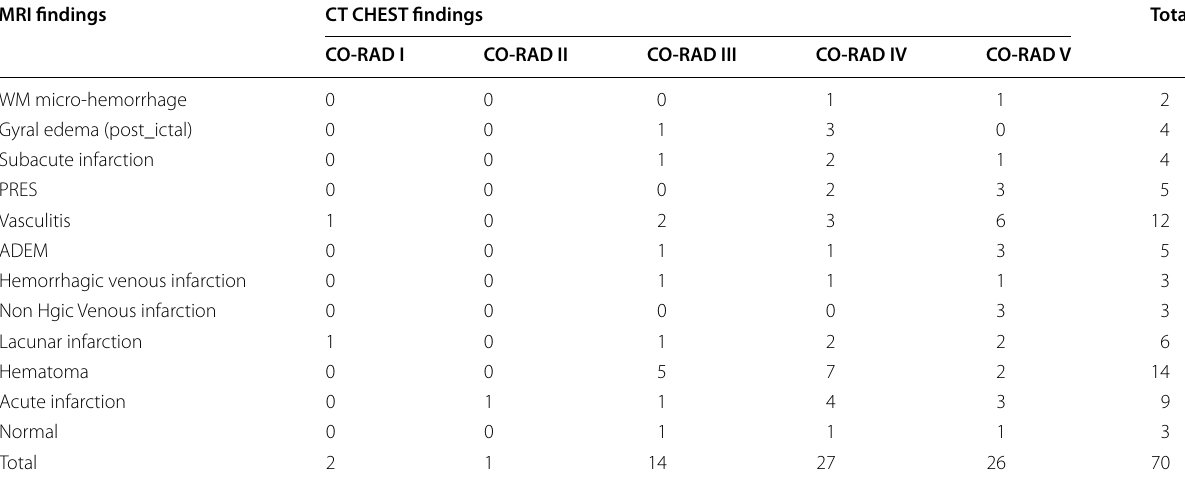
Table 5 Correlation between MRI findings and lung imaging MRI